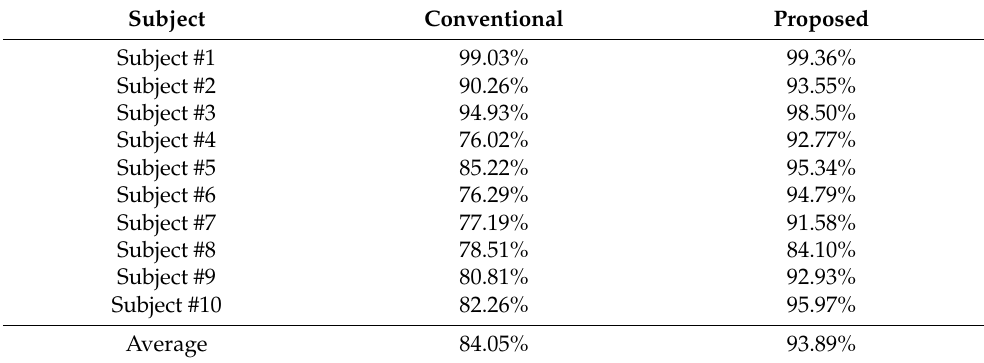
Table 2. Comparison of respiratory rate accuracy for the case shown in Figure